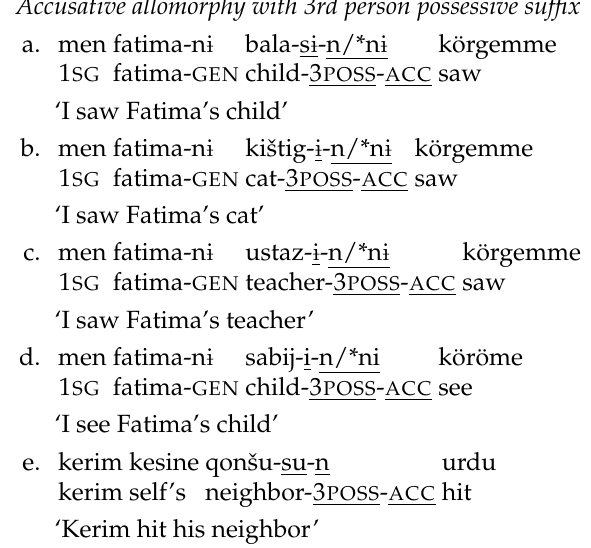
qan K a-da table- LOC